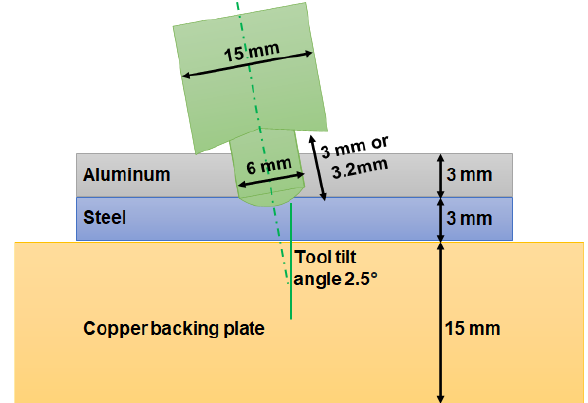
Figure 1. Schematic diagram of the tool and workpeice FSP setup.